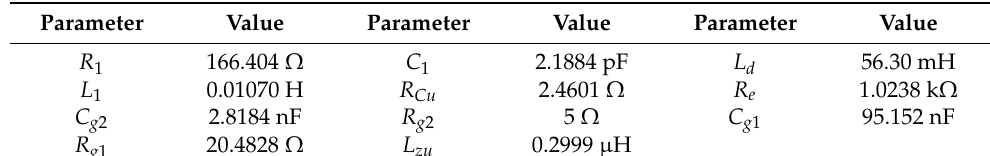
Table 1. Parameter identification results.